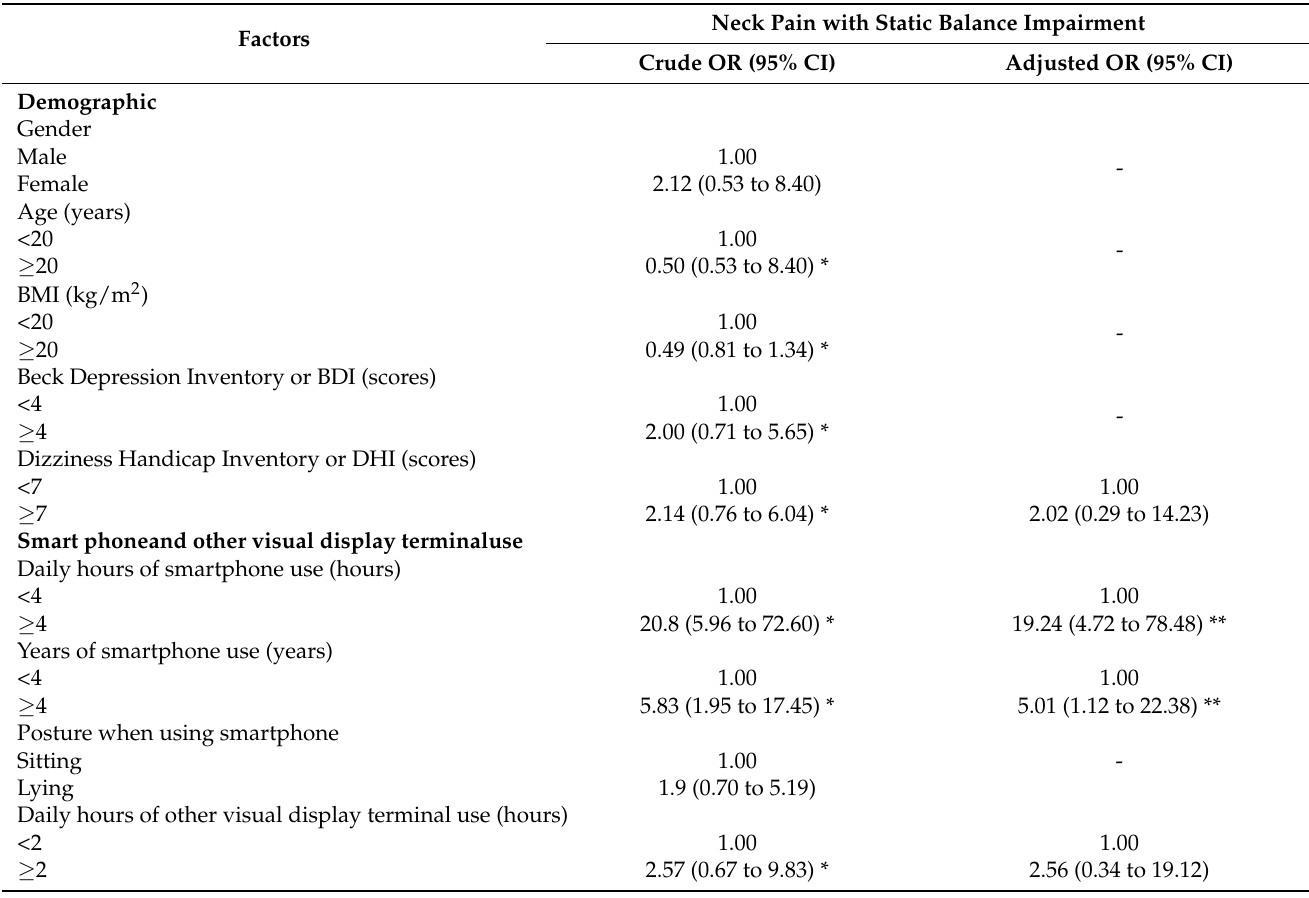
Table 3. Prevalence, adjusted OR and 95% confidence interval of balance impairment with risk factors by using simple and multiple logistic stepwise